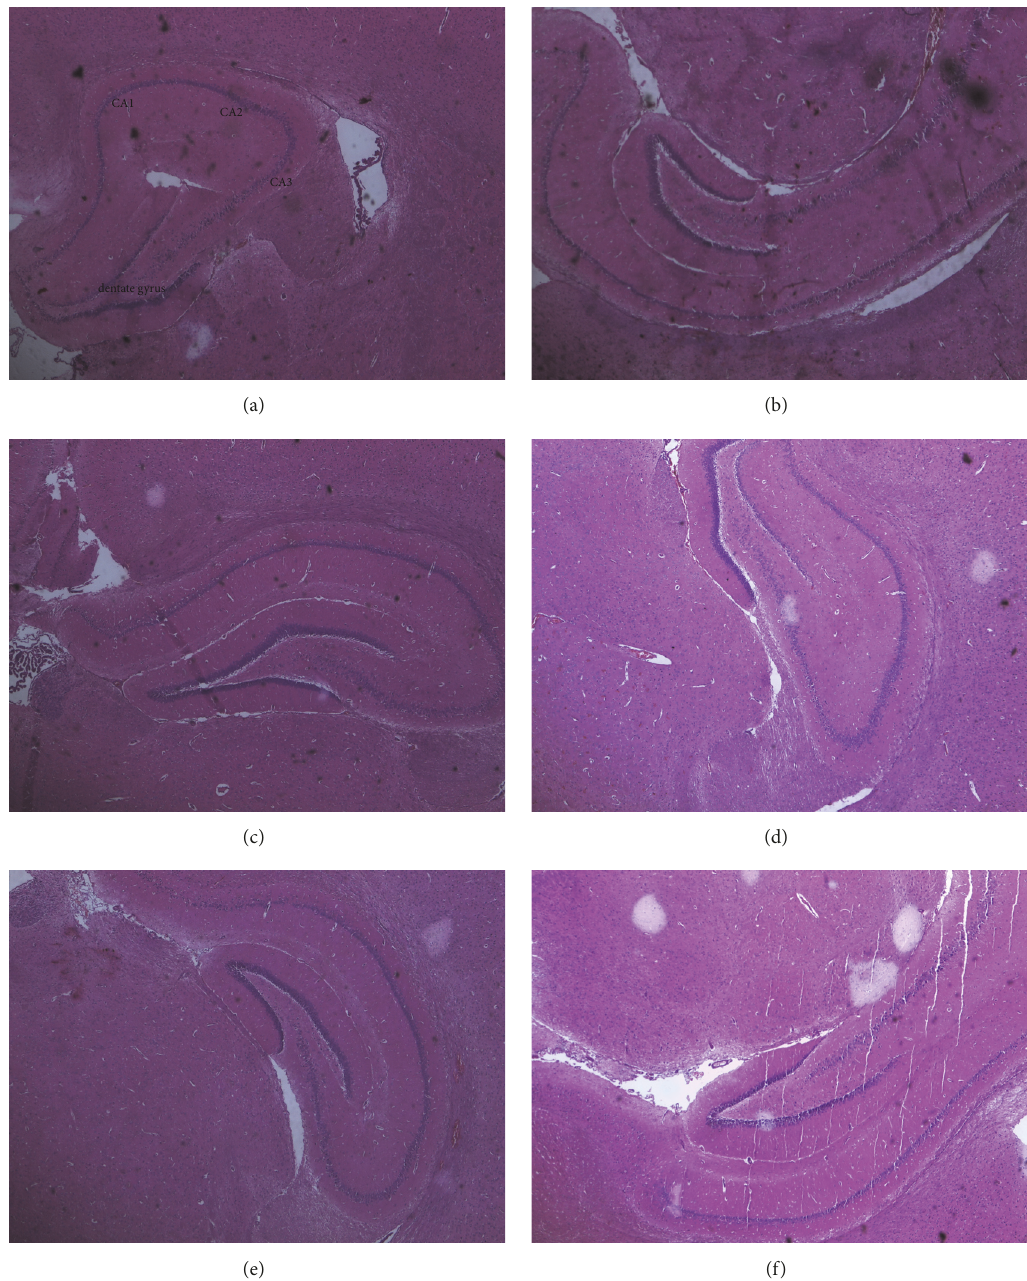
Figure 5: Photomicrograph of the sections of the brain in control rats (a) and rats treated orally with 30 mg kg −1 (b), 100 mgkg −1